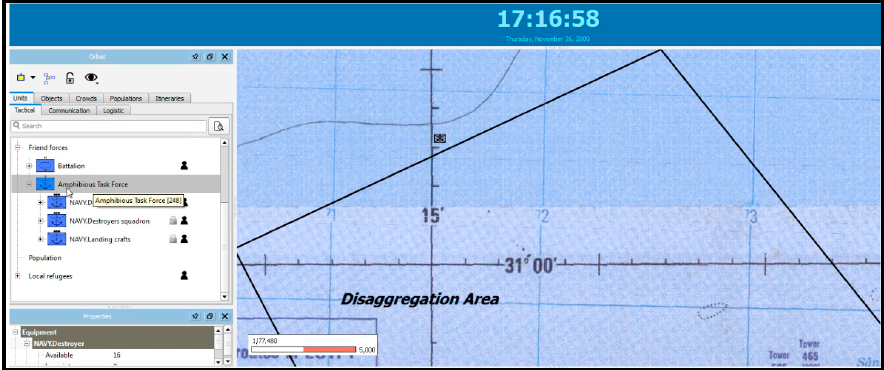
Figure 15. How to set a time trigger in MASA Sword.